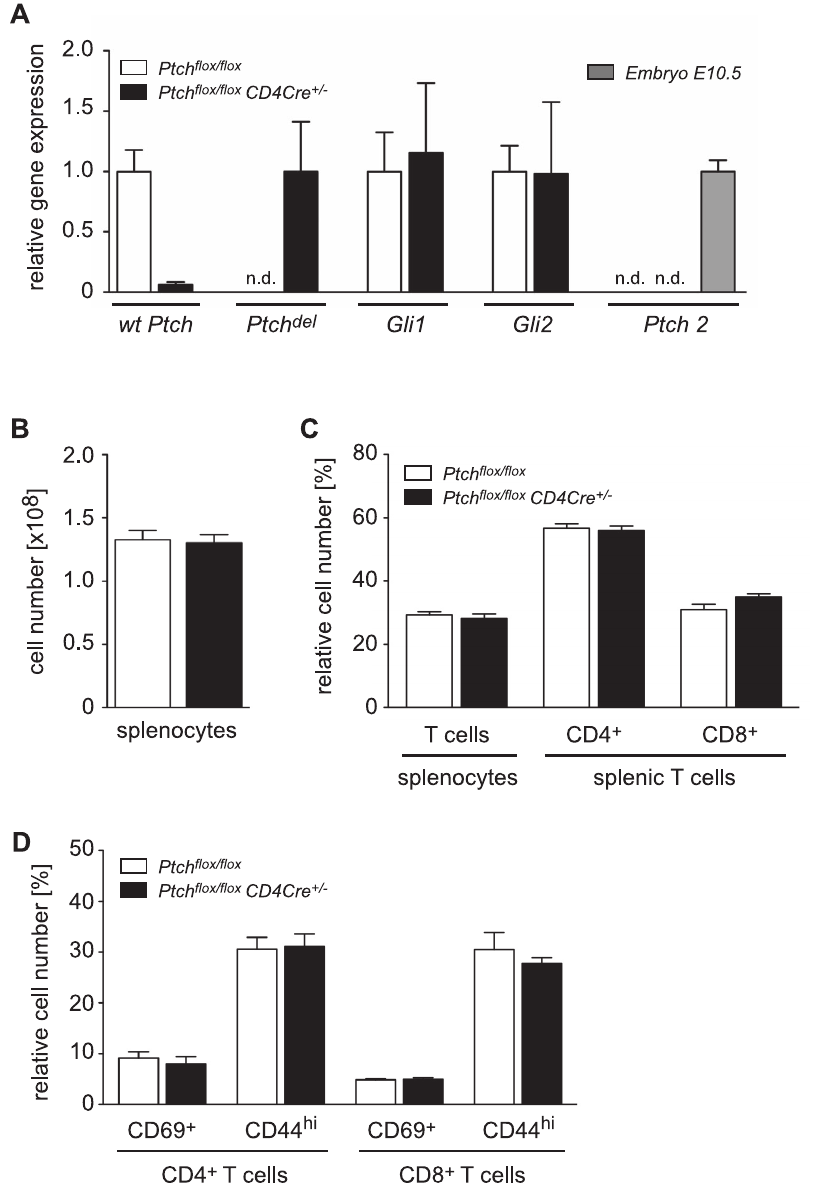
Figure 2. Gene expression and flow cytometric analysis of peripheral T cells. Splenic T cells were purified from Ptch flox/flox control or Ptch flox/ flox CD4Cre + / 2 mutant mice and used to generate cDNA for qRT-PCR analysis. Alternatively, total splenocytes were isolated from mice of each genotype and stained for TCR b , CD4, CD8, CD44 and CD69 to identify different peripheral T cell subpopulations. (A) Relative expression of wt Ptch transcripts derived from the Ptch flox allele, Ptch del transcripts after Cre-mediated recombination of the Ptch flox allele, Gli1 and Gli2 transcripts as well as Ptch2 transcripts are depicted. As a positive control for Ptch2 expression, cDNA from wt mouse embryos at stage E10.5 was used for PCR amplification. Gene expression was normalized to HPRT1 and the transcriptional level of each gene in Ptch flox/flox control mice or E10.5 embryos, respectively, was set to 1.0. All panels show the mean 6 SEM of five Ptch flox/flox and three Ptch flox/flox CD4Cre + / 2 mice; n.d.: not detectable. Measurement of all samples was performed in duplicates. (B) Mean number of total splenocytes 6 SEM is shown for ten Ptch flox/flox and eight Ptch flox/ flox CD4Cre + / 2 mice. (C) The percentages of T cells amongst all splenocytes and of CD4 + or CD8 + T cells amongst total splenic T cells is depicted. (D) T cells showing a recently activated (CD69 + ) or effector memory (CD44 hi ) phenotype were identified amongst the CD4 + and CD8 + splenic T cells. Panels C and D show the mean 6 SEM of five Ptch flox/flox and seven Ptch flox/flox CD4Cre + / 2 mice. Statistical analysis was performed by unpaired t-test (*: p , 0.05).